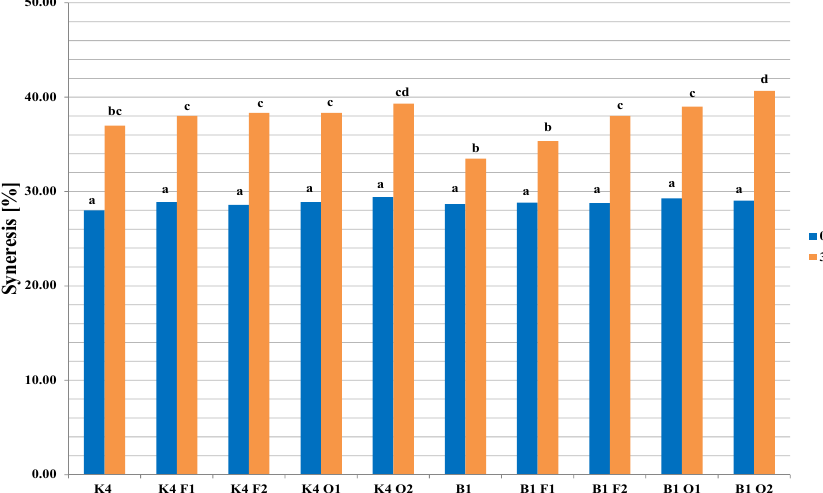
Figure 2. Syneresis in fermented milk samples at 0 and 35 days of storage. The samples are coded according to Materials and methods section, whereby values denoted by different letters represent statistically significant differences between variables (storage time and strains) ( p < 0.05) ( n = 3). The results for the color quality parameters of the fermented milk samples are shown in Table 4. The values of parameter L*, which indicates brightness, were in the range of 83.06–92.48 and increased significantly ( p < 0.05) up to day 21 of storage. The L* values were slightly higher for K4 samples. The values of the measured color parameters, such as the psychometric tone (a*), were negative up to day 35 of storage for both groups of fermented milk samples. Moreover, a* values decreased during storage up to 21 day. The calculated values for psychometric chroma (b*) for the samples were positive throughout the entire storage period, indicating the presence of yellow components such as the yellowish-green-colored riboflavin (vitamin B 2 ), β -carotene, and vitamin A molecules [32]. The b* values increased during storage in all samples up to day 21. Between day 21 and day 35 of storage, L* and b* parameters decreased, whereas a* values significantly increased in almost all samples. To ensure a comprehensive analysis of the effects of the different probiotic cultures and saccharide addition on the color of the fermented milk products, the total color difference parameter was calculated ( Δ E). It was found that the differences in color between samples with and without the addition of probiotics and prebiotics were unnoticeable, even for the inexperienced observer ( Δ E < 5).